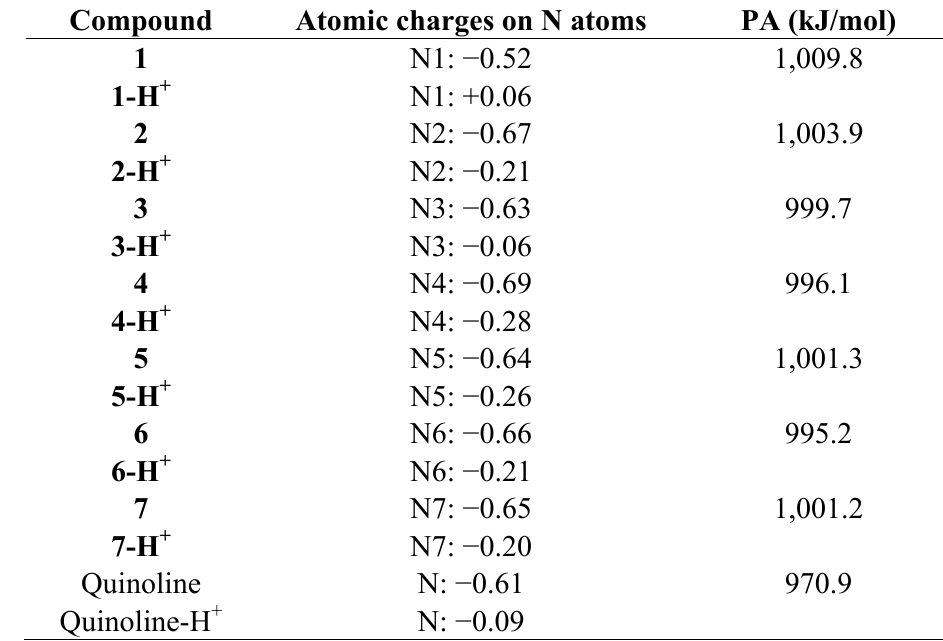
Table 1. Proton affinity values and estimated atomic charges on N atom for neutral and protonated monoaza[5]helicenes calculated at the B3LYP/6-311G** level of the theory (data pertaining to quinoline are used as reference).